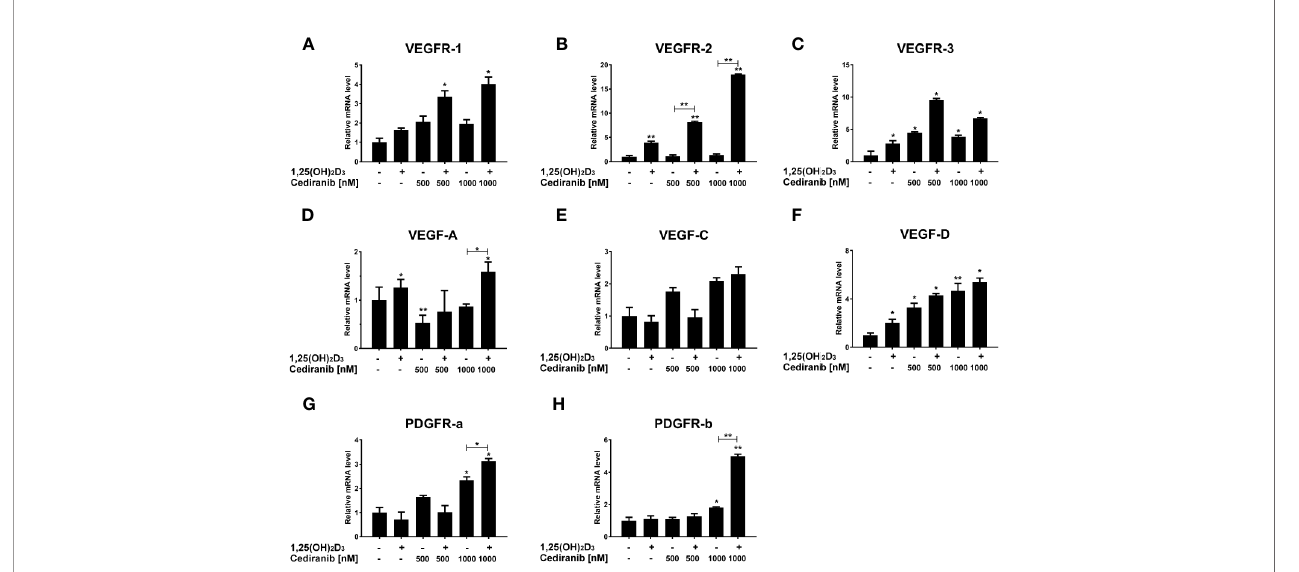
FIGURE 8 | The effect of 24-h preincubation with 1,25(OH) 2 D 3 at 100 nM concentration on VEGFR1 (A) , VEGFR2 (B) , VEGFR3 (C) , VEGFA (D) , VEGFC (E) , VEGFD (F) , PDGFRa (G) , and PDGFRb (H) gene expression in A375 melanoma cells treated subsequently for 24 h with cediranib at 500 or 1,000 nM concentration. mRNA levels were measured by qPCR. The results are representative of three experiments carried out in duplicate. * p < 0.05 and ** p < 0.01 vs. untreated control or between the two groups indicated by the